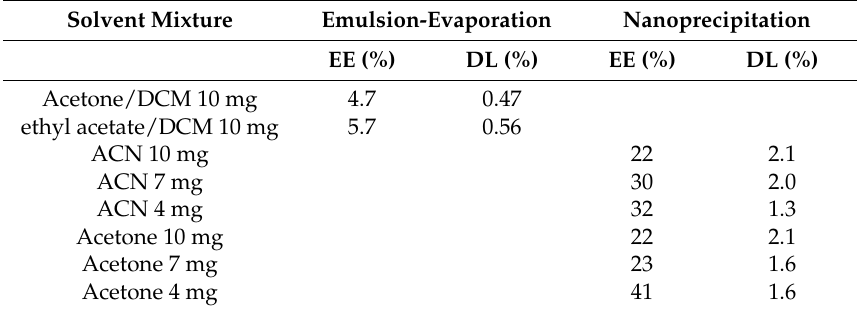
Figure 2. RSG release from nanoparticles in PBS at 37 °C, under sink conditions.